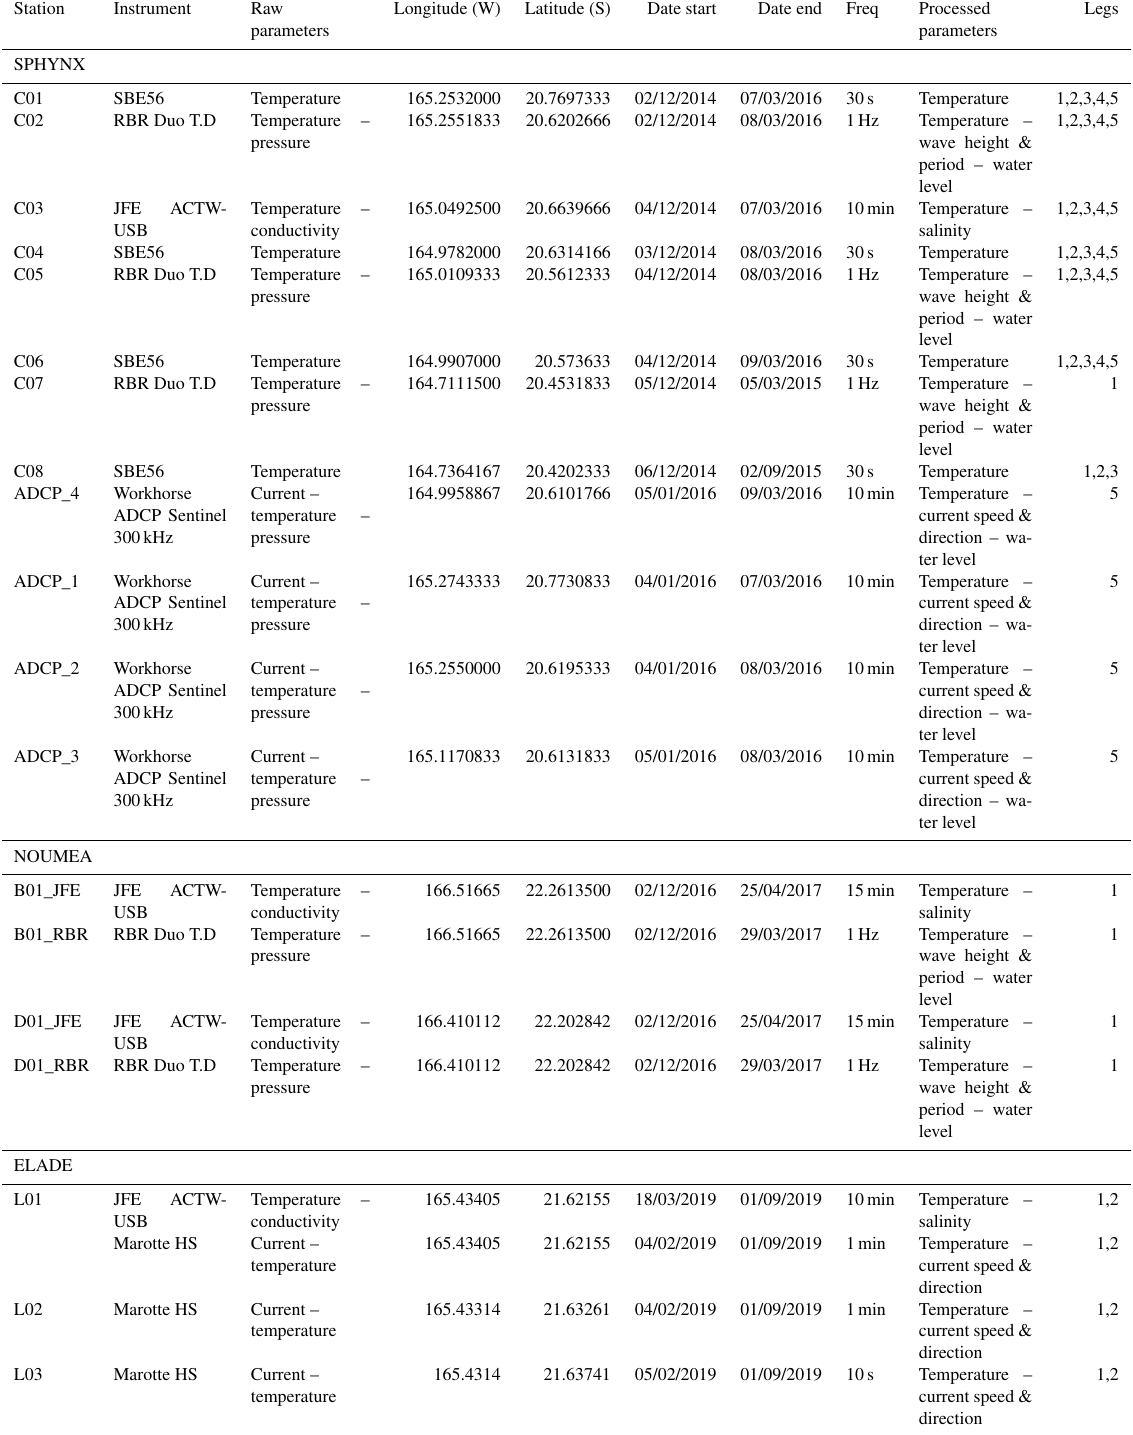
Table A1. Moorings and loggers information deployed during PRESENCE